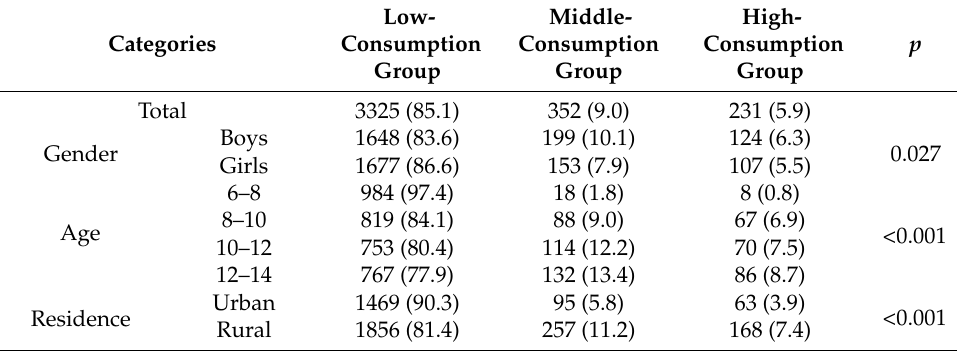
Table 5. Differences in sugar consumption level between different kinds of students ( n , %).